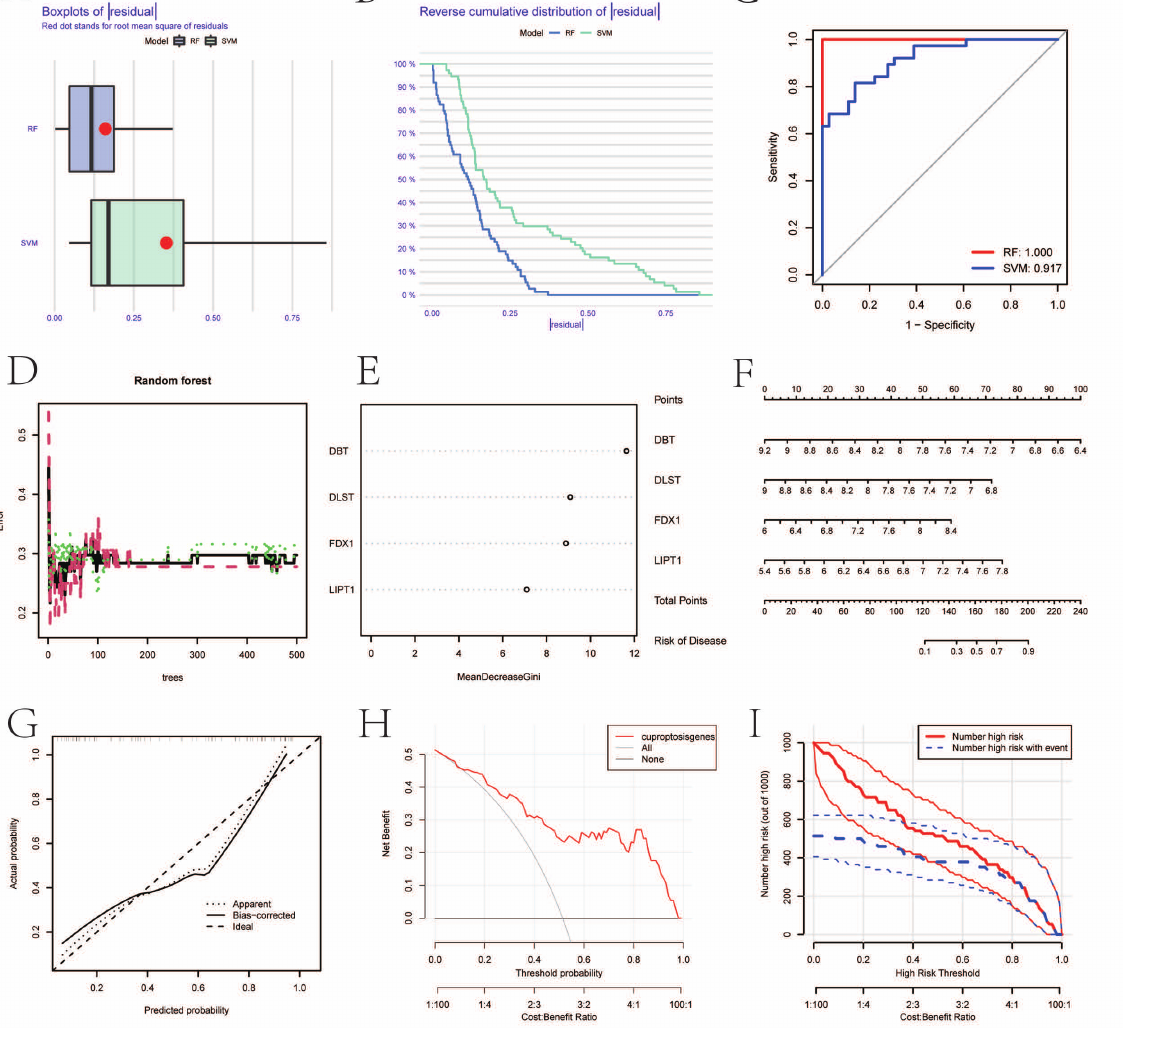
Figure 3. SVM and RF methods were used to screen hub genes. ( A – C ) Boxplot of the residual distribution ( A ), reverse cumulative distribution of residuals ( B ), and ROC curves ( C ) as a function of the values of observed sensitivity between RF and SVM. ( D ) RF prediction error curves based on 10-fold cross-validation. ( E ) The importance of the four CRGs based on the RF model. ( F ) Nomogram of the predictive model based on four CRGs. ( G ) Calibration curves showing that the nomogram model may be an ideal predictive model for OA. ( H , I ) DCA ( H ) and clinical impact plots ( I ) were used to determine the clinical utility of the risk prediction nomograms. SVM, support vector machine; RF, random forest; ROC, receiver operating characteristic; CRGs, cuproptosis-related genes; OA, osteoarthritis; and DCA, decision-curve